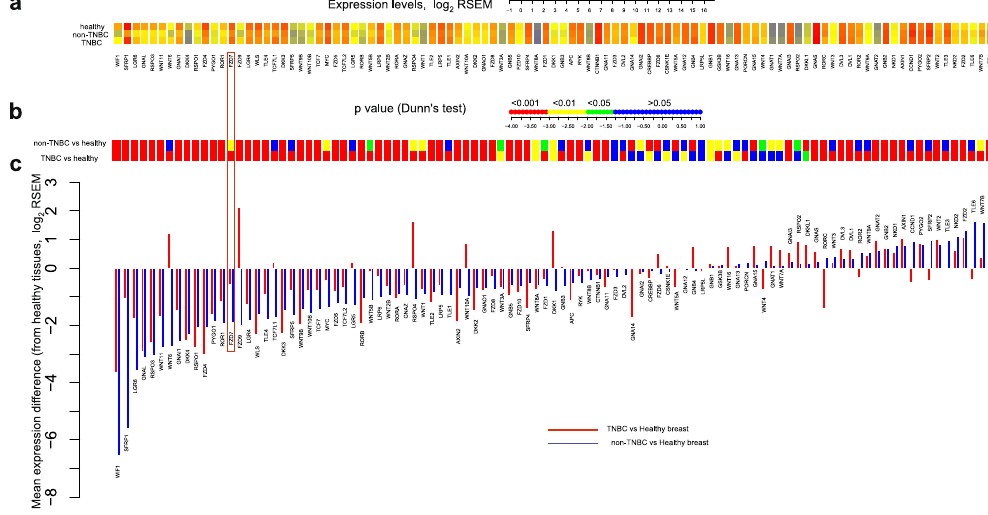
Figure 1. Expression levels of the Wnt pathway component genes in the TCGA tissue samples (113 healthy, 857 non-TNBC and 118 TNBC) ( a ) with p-values from Dunn’s multiple comparisons between them ( b ) and expression levels differences (relatively to healthy tissues) as a waterfall chart ( c ). FZD7 gene is highlighted on the figure (see manuscript